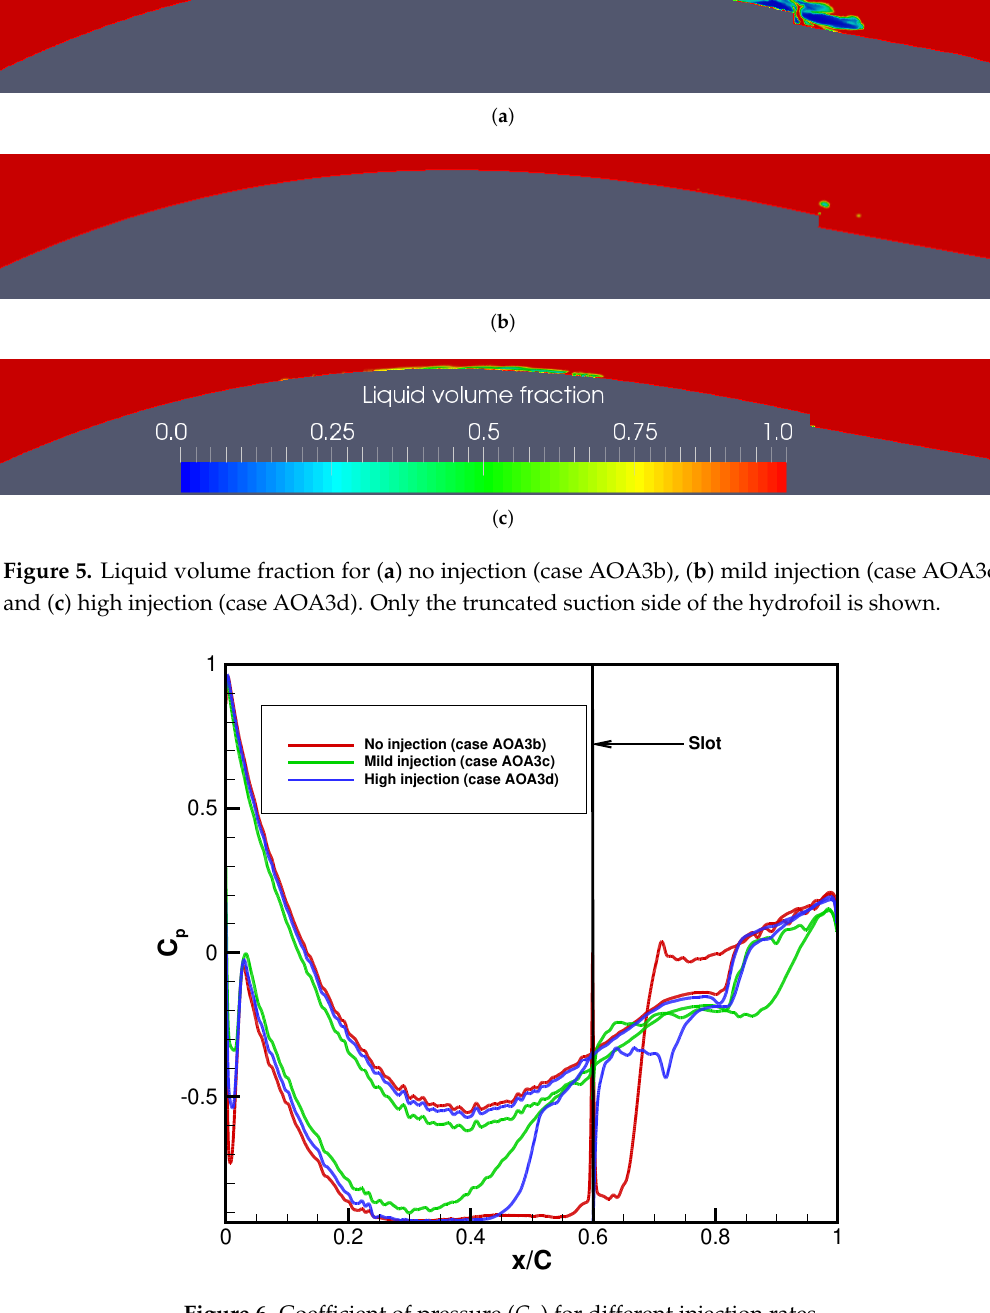
Figure 6. Coefficient of pressure ( C p ) for different injection